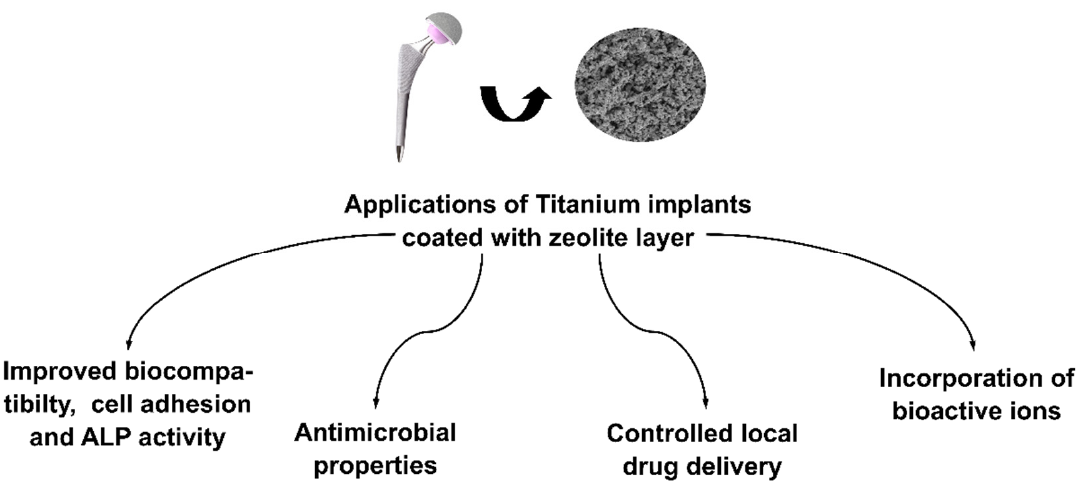
Figure 3. Applications of titanium implants coated with zeolite layer .